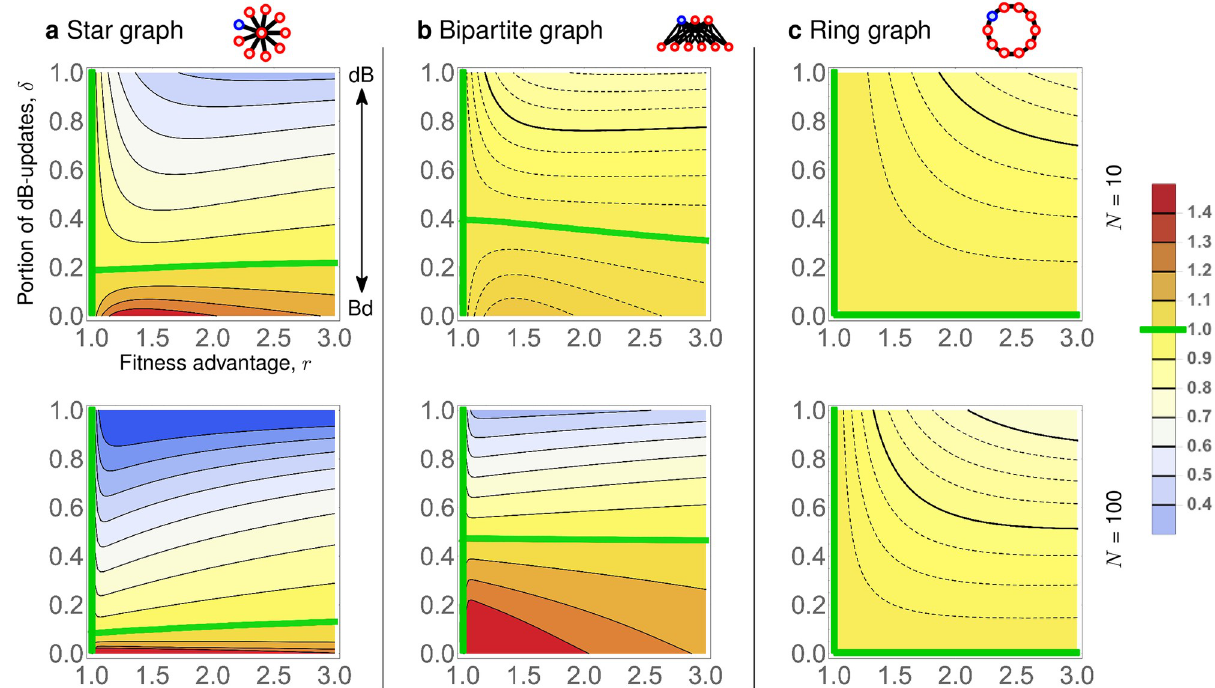
ffiffiffiffi p , and c , Ring graphs, of N ; r Þ = ^ r d ð K ; r Þ as a function of the fitness N N